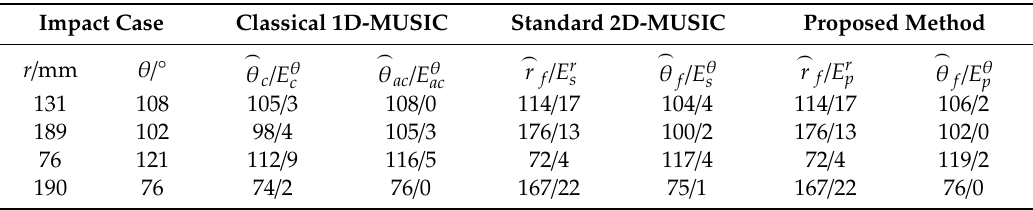
Table 3. Summary of estimated results and